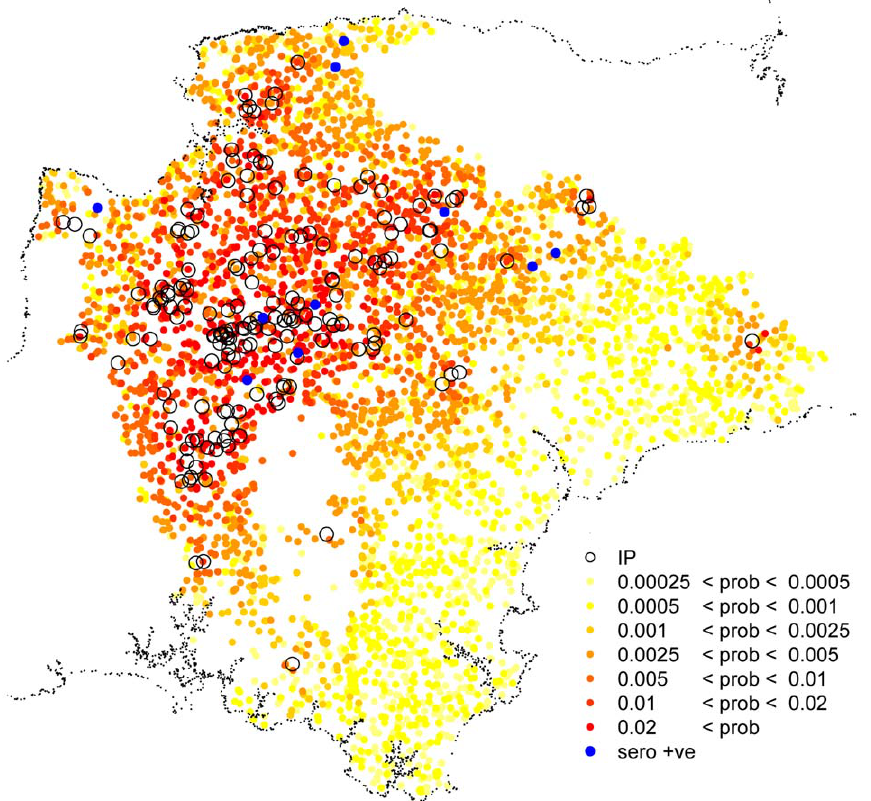
Figure 1. Risk-map for undiscovered infection. Estimated risk that individual sheep/mixed farms may be infected but undiscovered with foot- and-mouth disease at the end of the UK 2001 outbreak in the county of Devon. Farms classified as infected premises (IP) in 2001 are shown as black circles. The ten farms found to be sero-positive in 2001 after the epidemic are also shown (blue dots). doi:10.1371/journal.pone.0020064.g001 PLoS ONE |